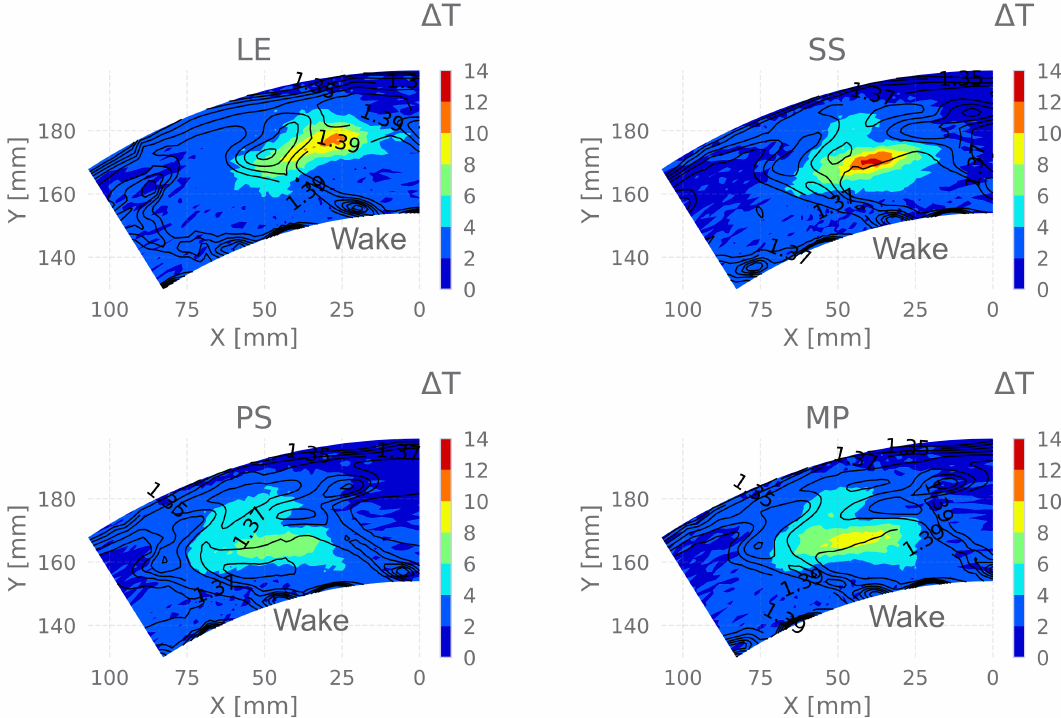
Figure 10. Peak-to-trough temperature contours at different injection positions at plane T2. The black line contour is the total pressure (bar A